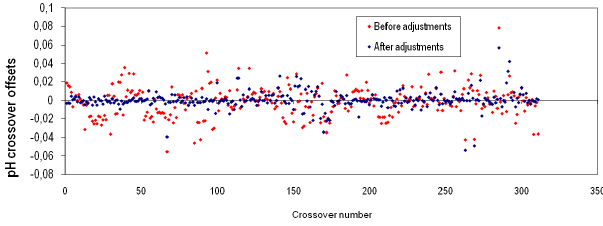
Figure 4. Crossover pH o ff sets obtained with original database and after adjustments were